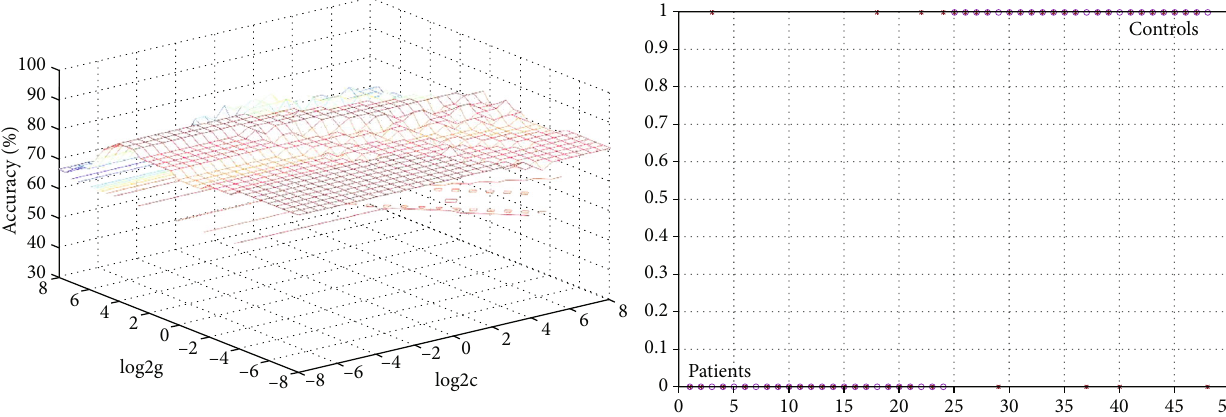
Figure 2: 3D view of the classi fi ed accuracy with the best parameter using GFC in the right precentral gyrus/postcentral gyrus/paracentral lobule to di ff erentiate the patients from the controls. The result was obtained in LIBSVM using a “ leave-one-out ” approach with default Gaussian kernel. GFC: global-brain functional